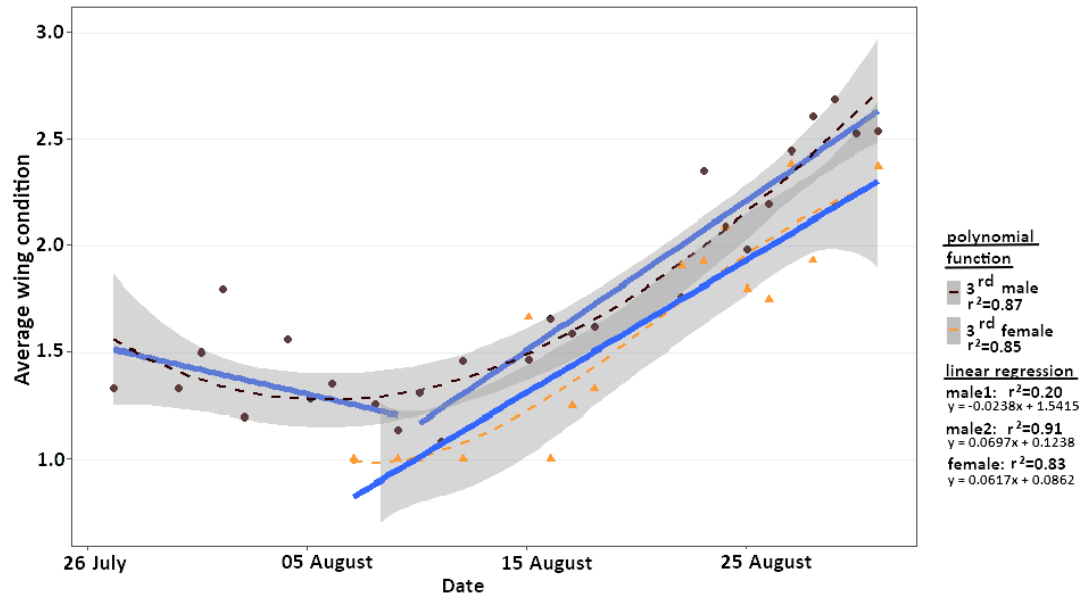
Figure 2. Changes in the average wing condition during the 2019 flight season of Erebia pronoe are categorised by sex. Males are indicated by brown circles, and females are indicated by orange triangles. Linear trends for both sexes are given and are based on the 3rd polynomial function. The 95% confidence interval of the polynomial function is given in grey.